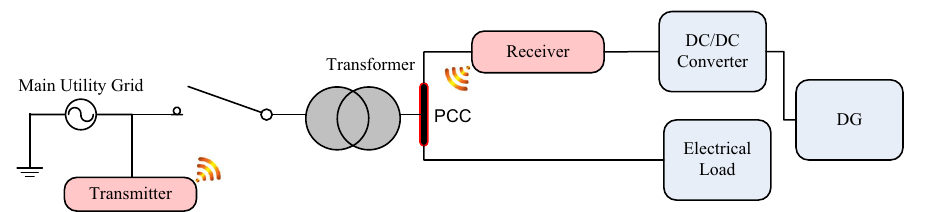
Fig. 3 A schematic of remote islanding detection